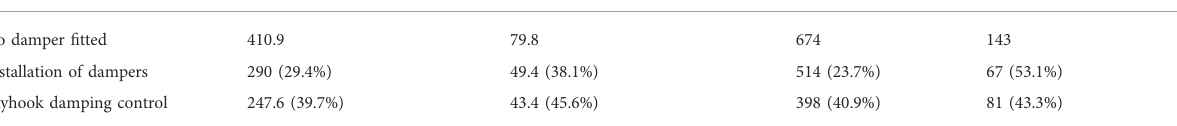
TABLE 4 Peak and RMS values of torsional vibration response for uniform speed conditions. Torsion control